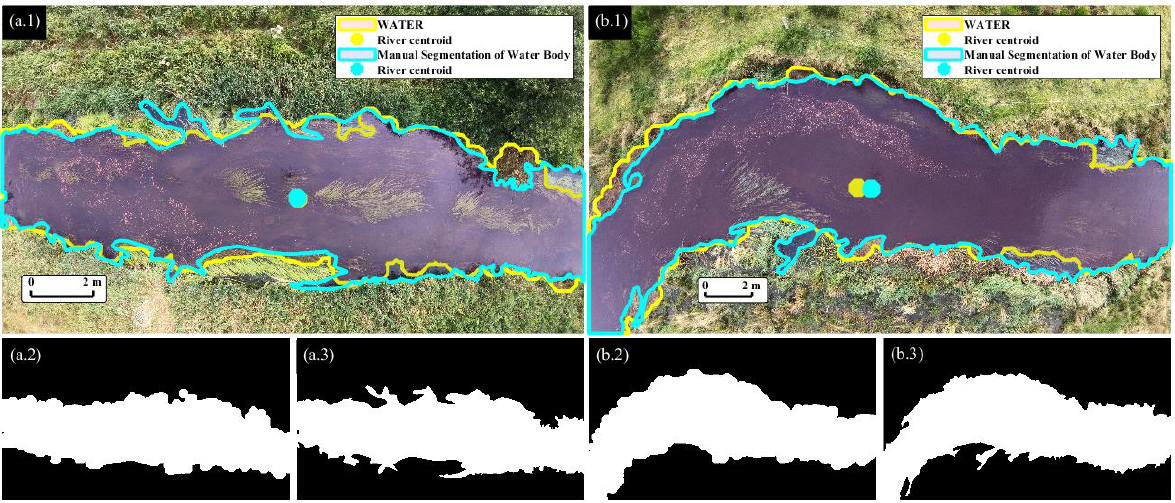
Figure 8. Illustration of automatic and manually based water segmentation. ( a.1 ) River Vejle Å, section XS1 (ID: 23 in Supplementary Material E), presenting a high density of aquatic vegetation. Automatic (yellow) and manually based (cyan) water segmentation. Dots are the centroids of the segmented water extent. ( a.2 ) Mask computed by WATER (automatic analysis). ( a.3 ) Mask by manual segmentation. ( b.1 ) River Grindsted Å’, section ST6 (ID: 12 in Supplementary Material E), presenting patches of aquatic vegetation and concentrated seeding density. Automatic (yellow) and manually based (cyan) water segmentation. Dots are the centroids of the segmented water extent. ( b.2 ) Mask computed by WATER (automatic analysis). ( b.3 ) Mask by manual segmentation.